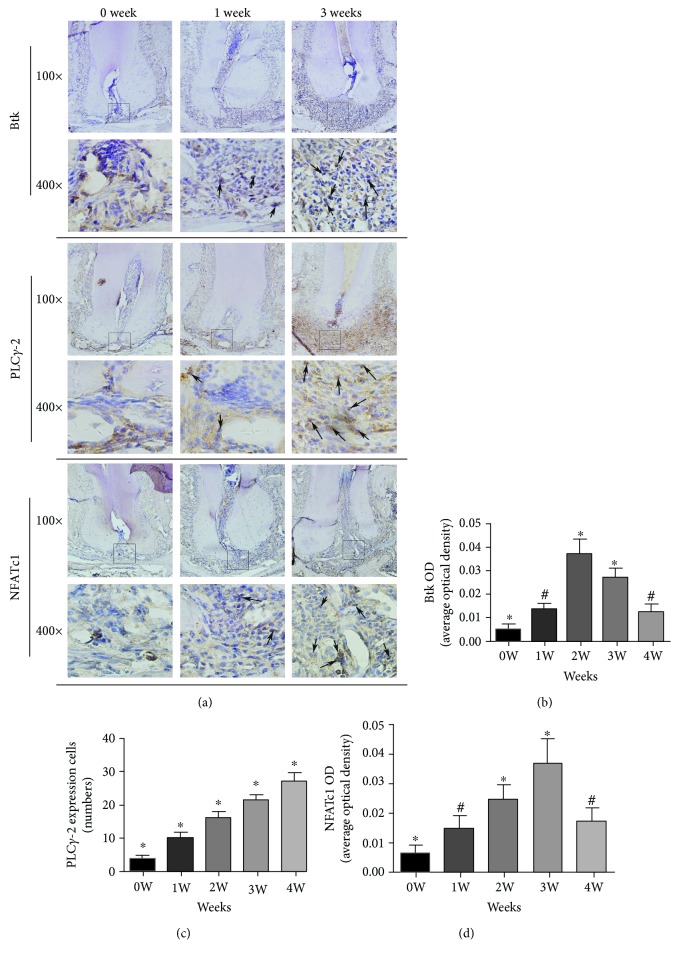
Expression of Btk, PLCγ2, and NFATc-1 in periapical tissues of mice at various time points. (a) shows the immunohistochemical staining images of Btk, PLCγ2, and NFATc-1 at 0, 1, and 3 weeks, respectively, at ×100 and ×400. (b–d) show the statistical results for the proportion of positive cells at different time points. Black arrows indicate positive cells. ∗P < 0.05 represents a significant correlation between different groups. #P > 0.05 represents no significant correlation between the two groups.